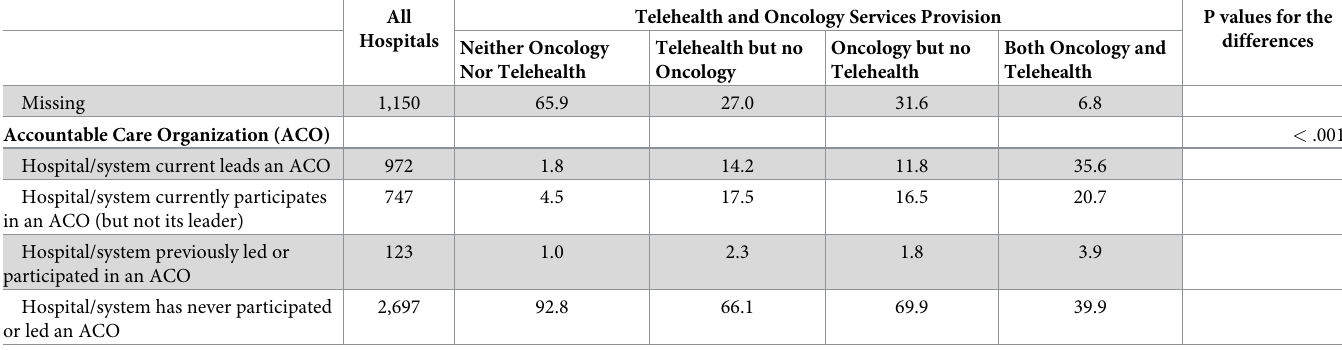
PLOS ONE | https://doi.org/10.1371/journal.pone.0281071 January 31,